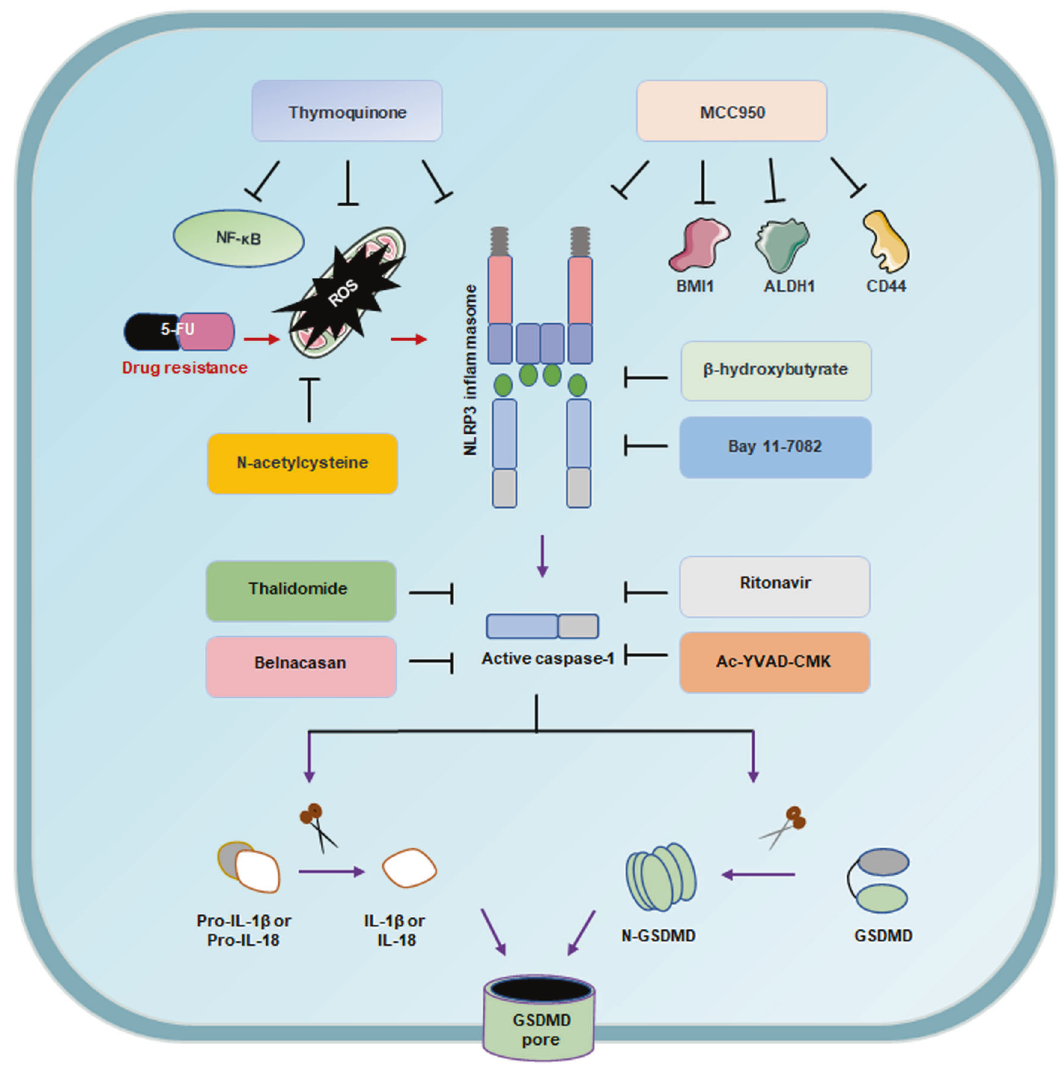
Fig. 6 The status of current NLRP3 in fl ammasome and caspase-1